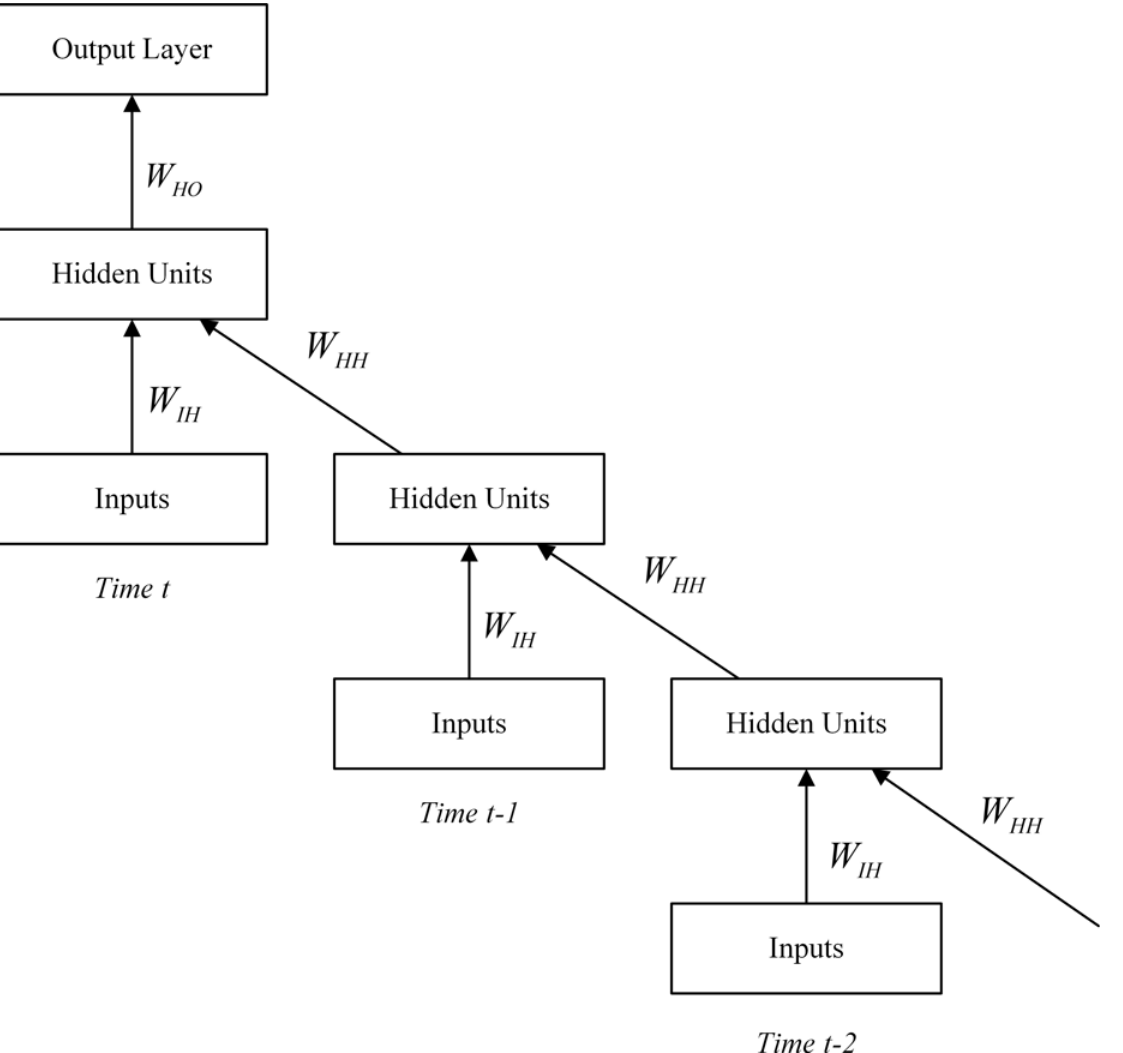
Fig 3. BackPropagation Through Time for